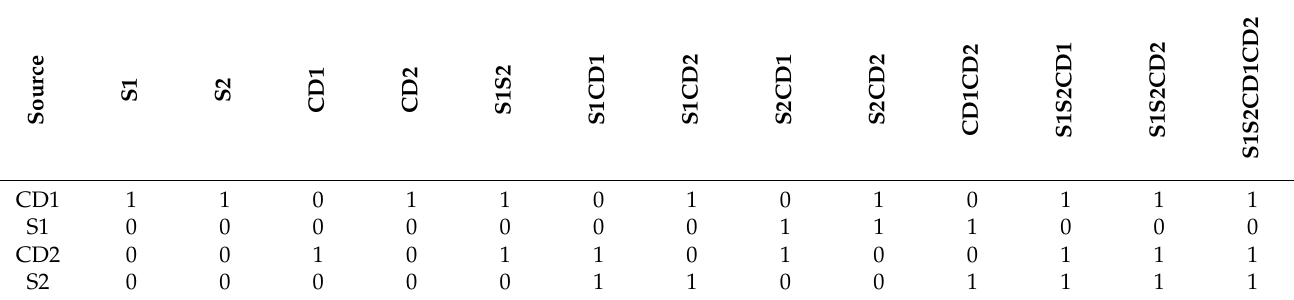
Table 3. Truck motion matrix at the origins.